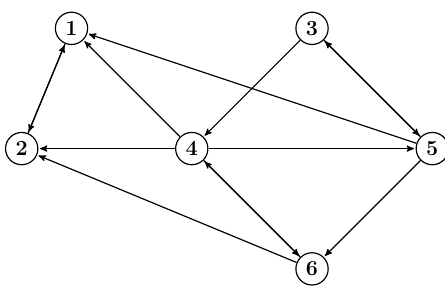
Figure 2: Unilaterally connected D ( w